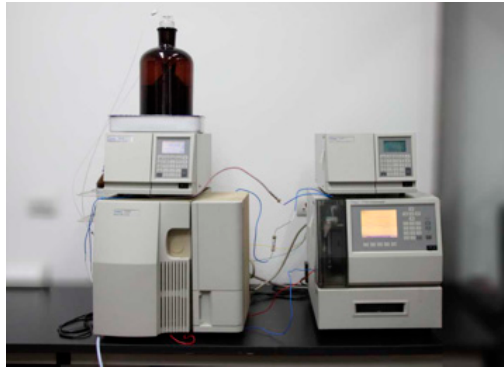
Figure 2. Gel permeation chromatography (GPC) system.